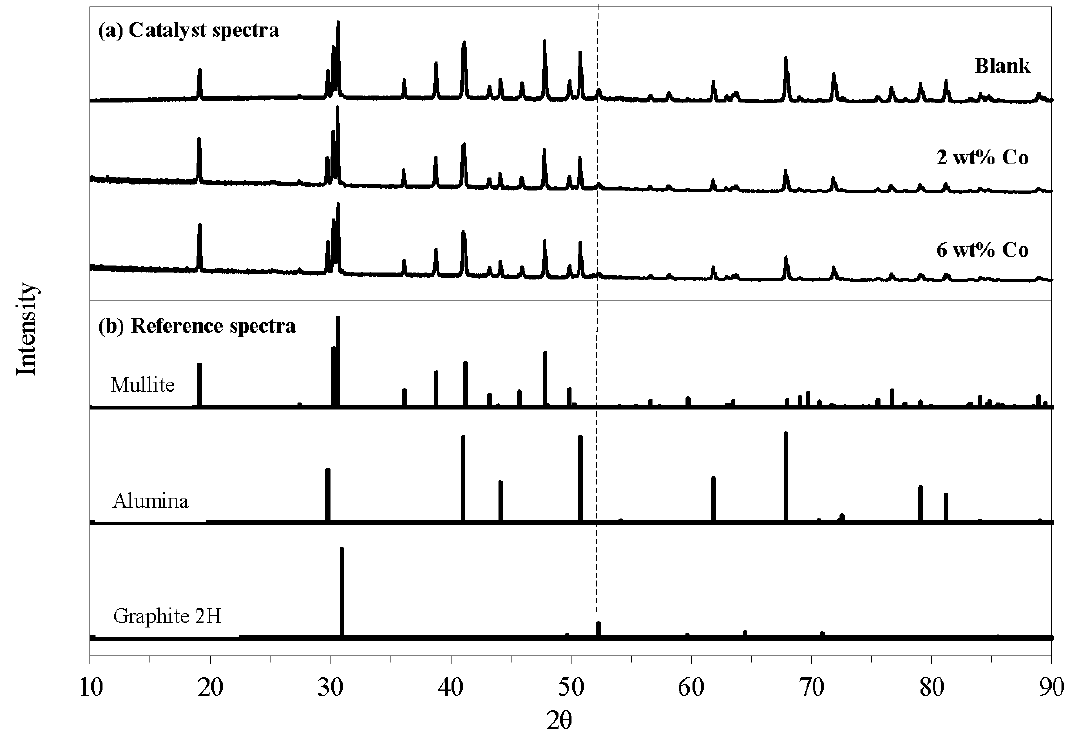
Figure 24. XRD plots of ( a ) catalyst peaks and ( b ) reference peak